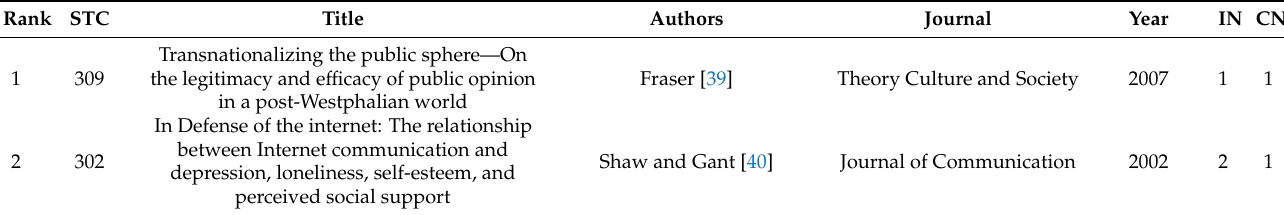
Table 5. The top 10 papers with the most citations,